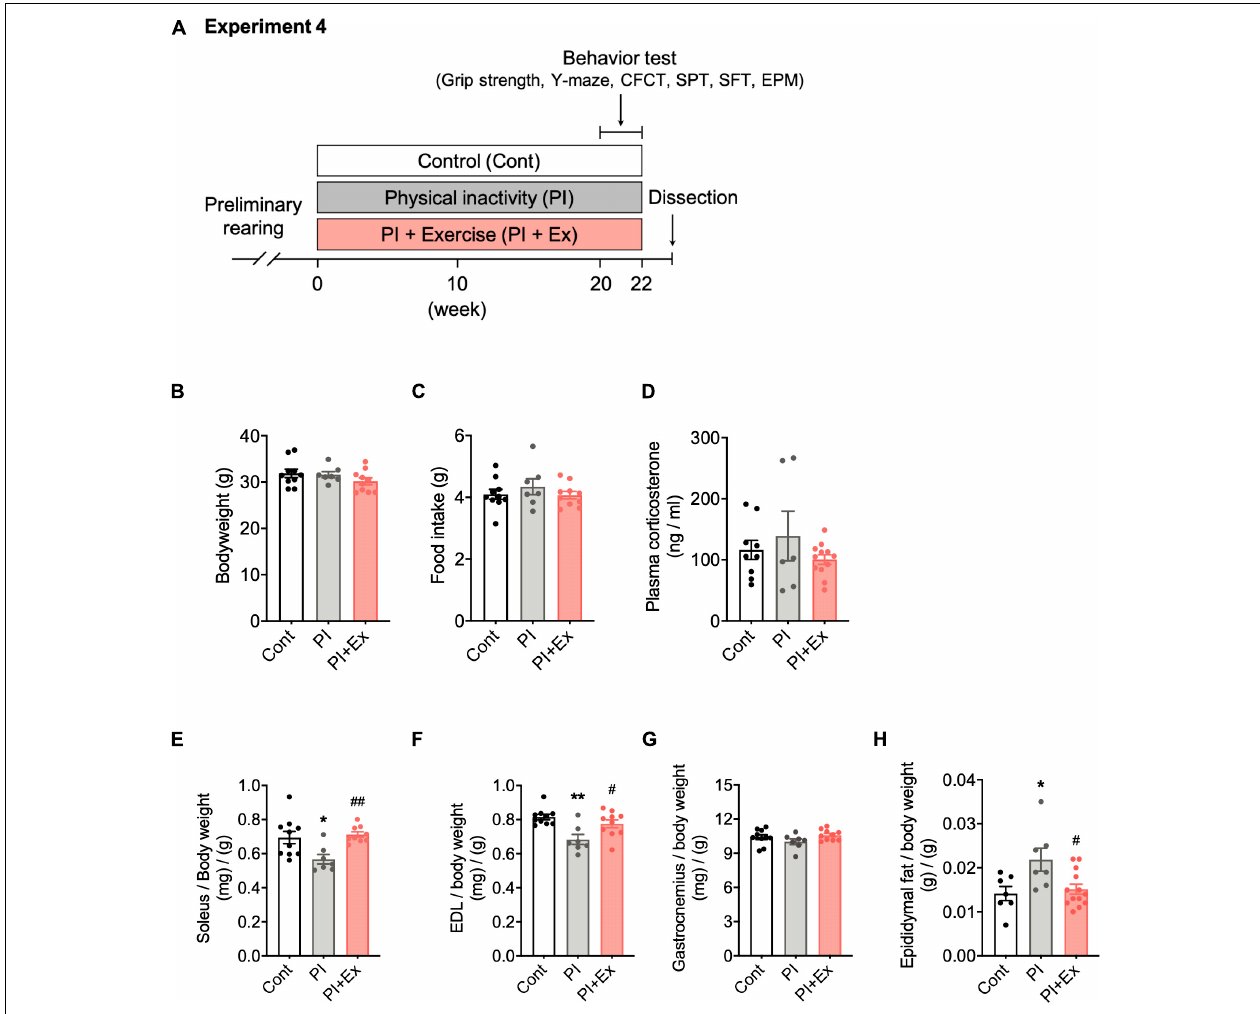
FIGURE 5 | Regular low-intensity exercise prevented muscle weight loss and fat mass gain from housing in the PI cage. (A) Experimental design for physical inactivity housing for 20 weeks and cognitive testing. (B) Body weight. (C) Food intake on 20th week. (D) Plasma corticosterone concentration on 20th week. (E–G) Soleus, Extensor digitorum longus (EDL), and Gastrocnemius muscle weight normalized to body weight. (H) Epididymal fat weight normalized to body weight. All data are presented as the mean ± SEM (Cont mice, n = 10; PI mice, n = 7; PI + Ex mice, n = 10). Data were analyzed using one-way ANOVA with Tukey’s post-hoc test. *p < 0.05, **p < 0.01 compared with the Cont mice and # p < 0.05, ## p < 0.01 compared with PI